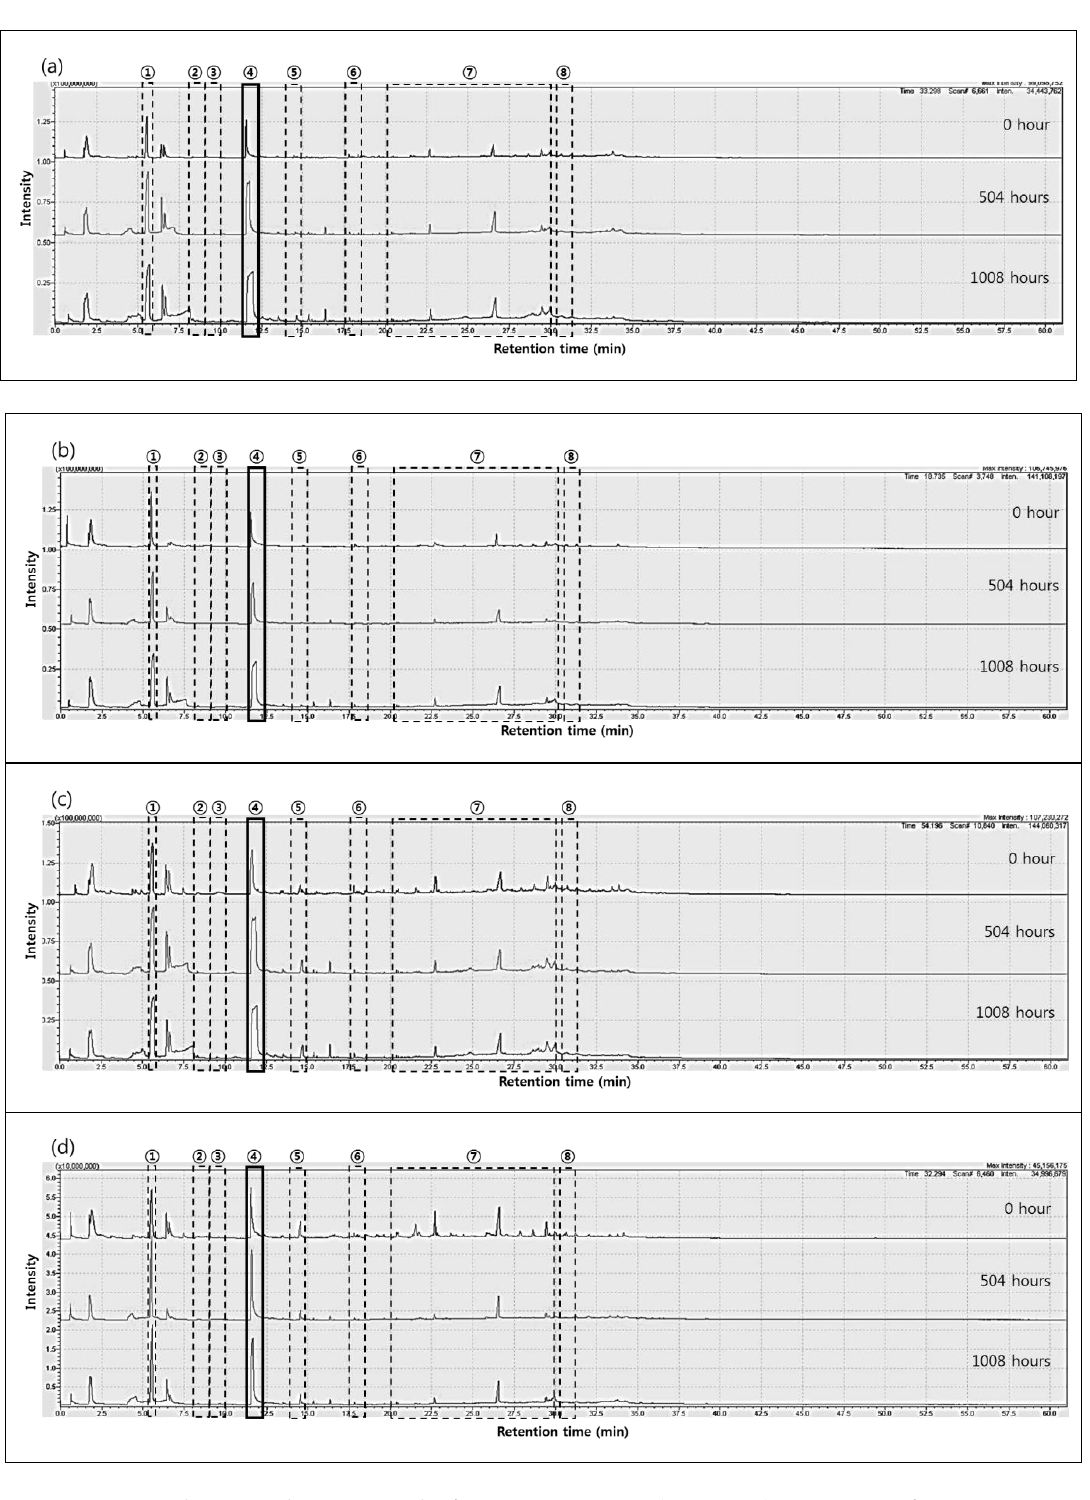
Figure 4. Pyrolysis-gas chromatography/mass spectrometry (py-GCMS) pyrograms of composites ( a ) D, ( b ) Z, ( c ) K, and ( d ) A with respect to immersion time.